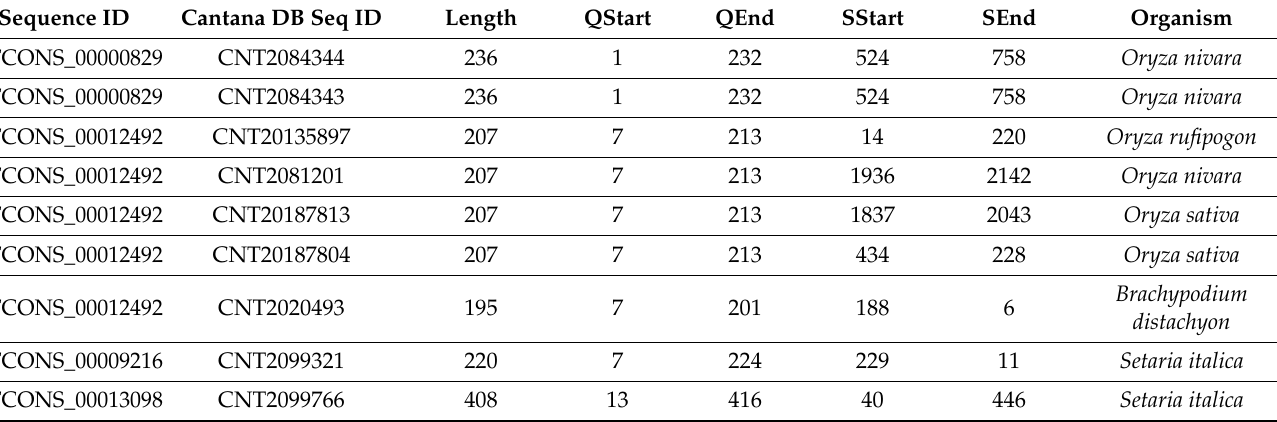
Table 4. Significant blast results from CANATAdb.